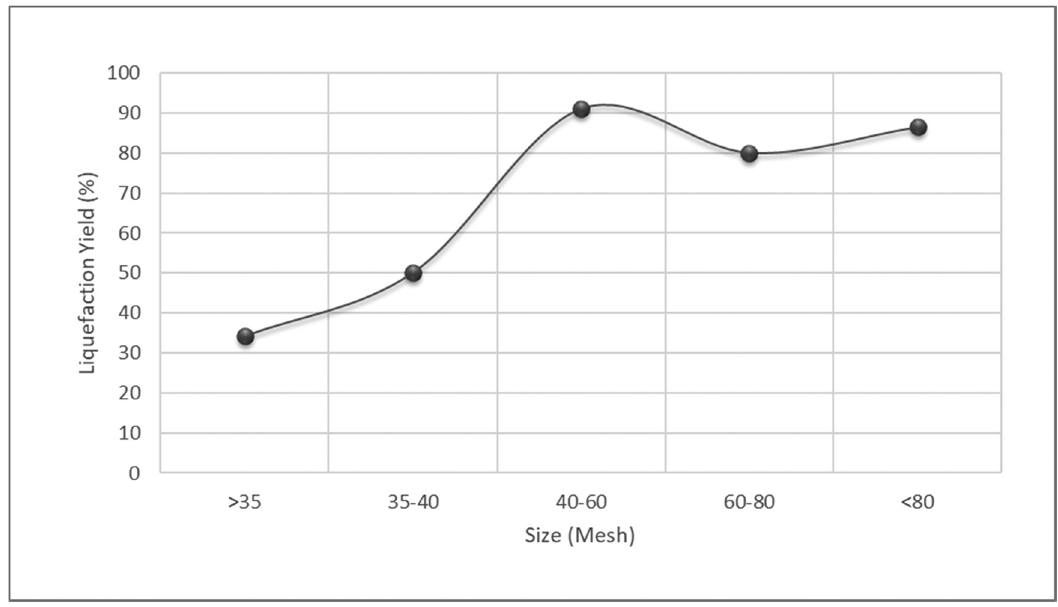
Figure 1: Liquefaction yield ( % ) with fraction ( mesh ) for